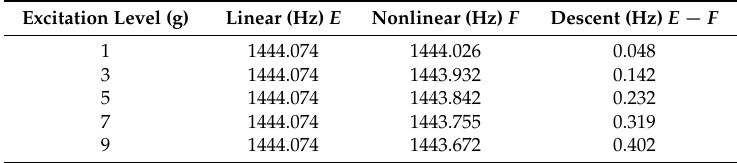
Table 7. The 3 order linear and nonlinear resonant frequencies of the hard-coating cylindrical shell under different excitation